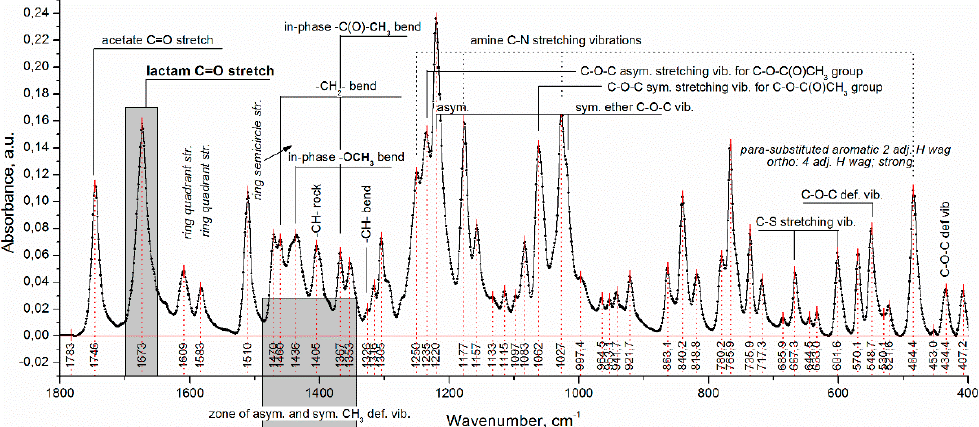
Figure 2. Attenuated total reflectance Fourier transform infrared (ATR-FTIR) spectrum of diltiazem base.